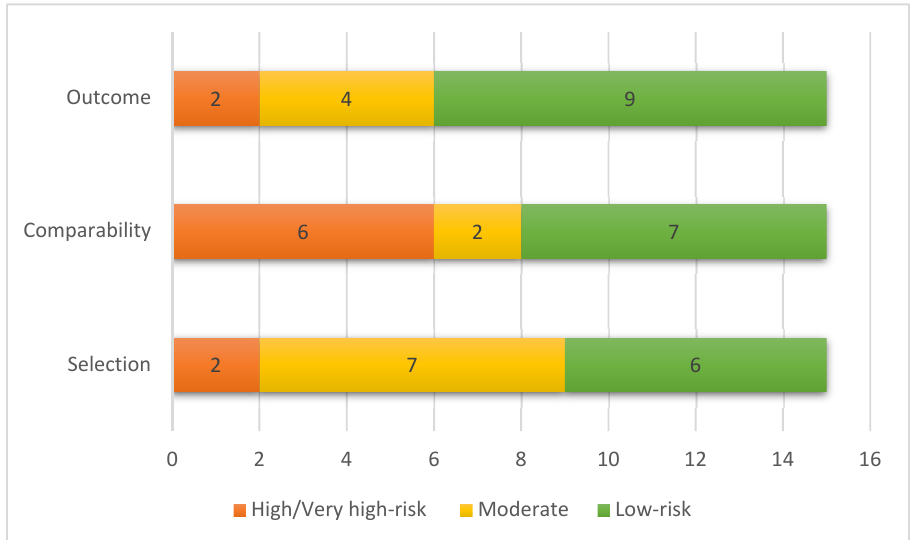
Figure 2. Pooled risk of bias of studies, according to New-Castle Ottawa main domains .